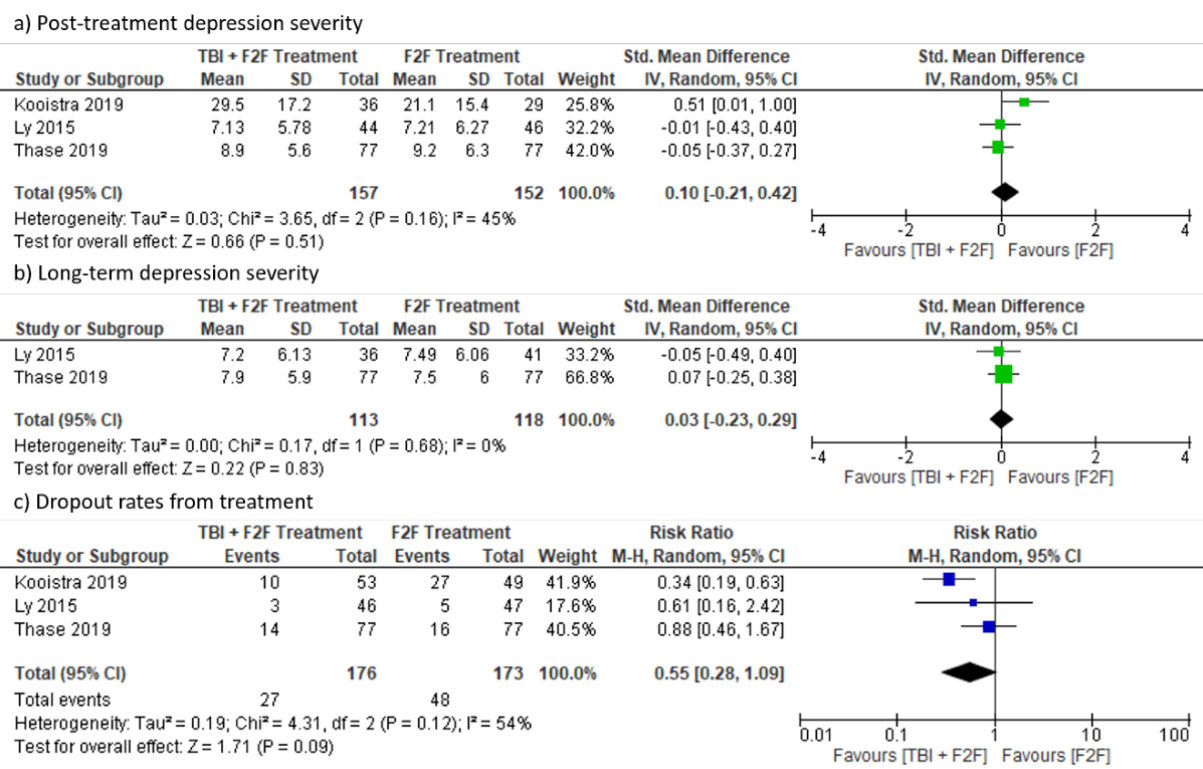
Figure 9. Forest plots for blended treatments (noninferiority